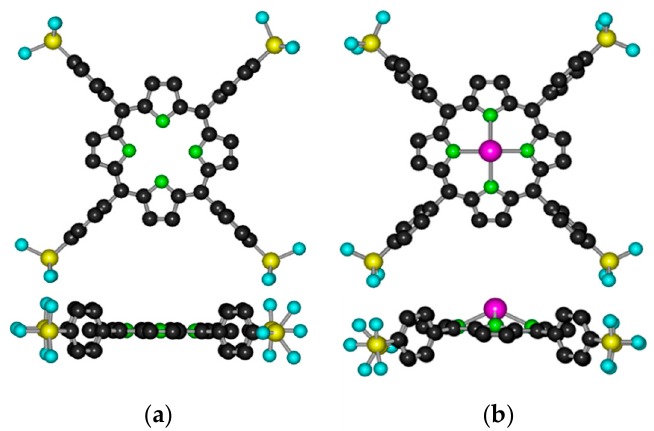
Figure 1. Top- and side-views of ( a ) the free-base 5,10,15,20-tetrakis(4-sulfonatophenyl)porphyrin and ( b ) its (out-of-plane) lanthanide(III) complex. (The hydrogen atoms are omitted for clarity.) Lanthanides (abbreviated as Ln) are a series of elements with atomic numbers 57–71, located in the first row of the f -block in the periodic table. Lanthanides usually form cations with a +3 oxidation state, and the radius of the Ln 3+ ions decreases from left to right in the periodic table; this is the well-